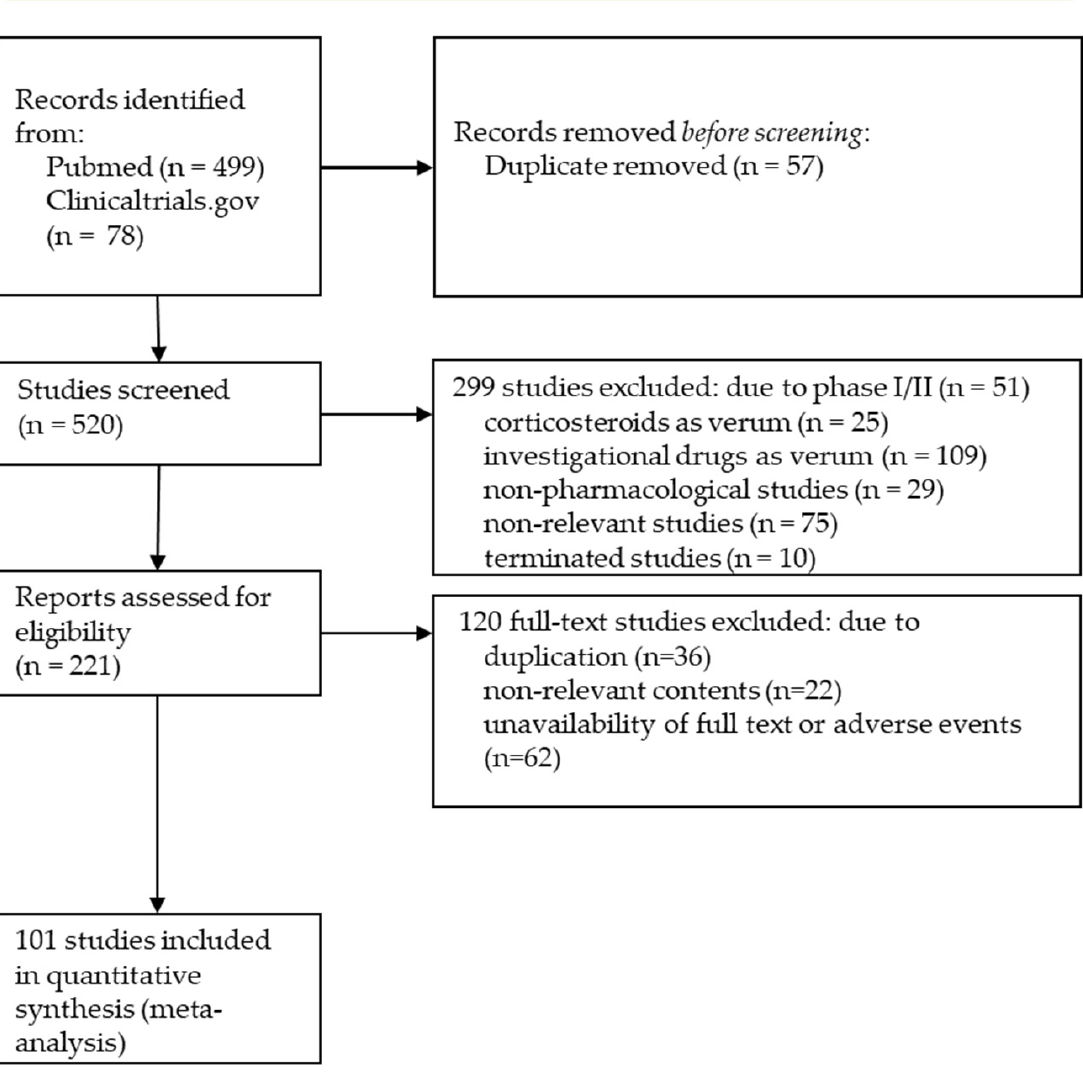
Table 1. Patients’ demographics and disease characteristics of placebo groups according to the study of verum medication.